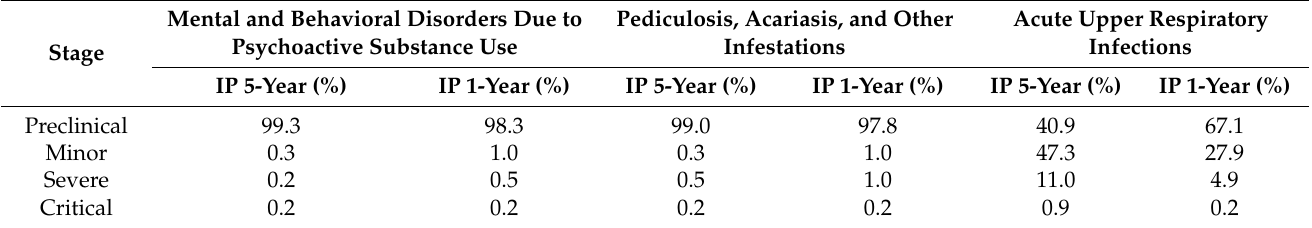
Table 12. Changes in the distribution of acute diseases among common dementia risk